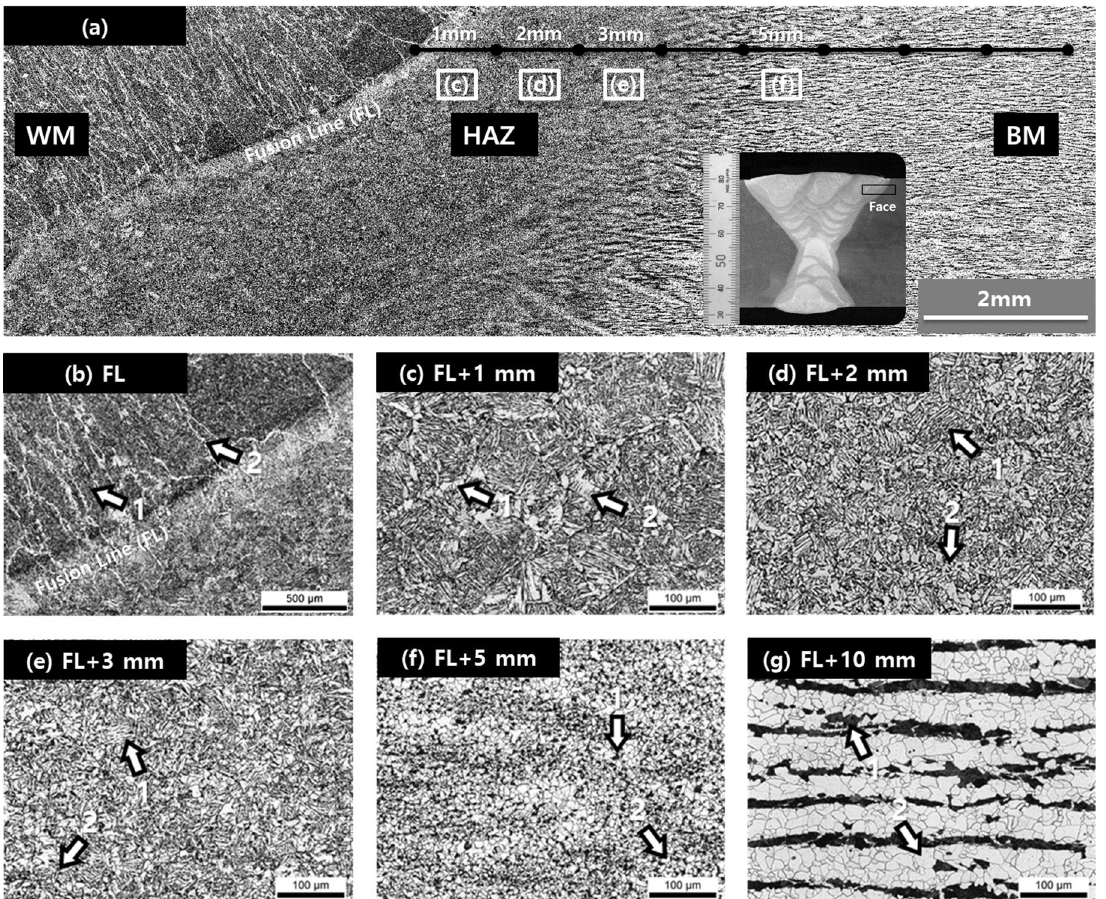
Figure 6. Optical micrographs of the weldment with butt joint manufactured by SAW on the 70 mm thickness: ( a ) The weldment; ( b ) the fusion line: 1—acicular ferrite, 2—grain boundary ferrite; ( c ) fusion line + 1 mm: 1—grain boundary ferrite, 2—upper bainite; ( d ) fusion line + 2 mm: 1—upper bainite, 2—intragranular ferrite; ( e ) fusion line + 3 mm: 1—upper bainite, 2—fine pearlite; ( f ) fusion line + 5 mm: 1—fine lamellar pearlite, 2—fine polygonal ferrite; ( g ) fusion line + 10 mm: 1—lamellar pearlite, 2—polygonal ferrite.